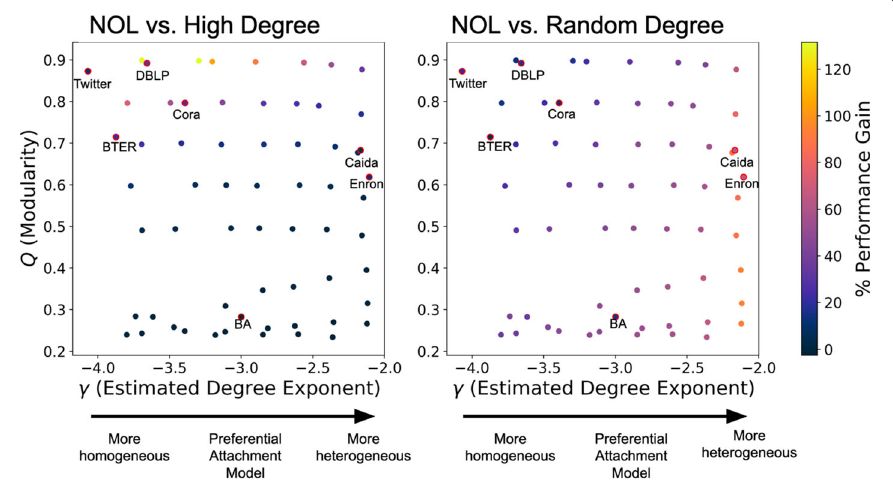
Fig. 6 Results of NOL-HTR parameter search on k and (cid:4) show benefits and limitations of learning in this setting. Experiments over 56 LFR networks generated using different values of parameters γ , the estimated exponent of the degree distribution (horizontal axis), and μ , the extent of cross-community links, which governs modularity Q (vertical axis). Color of points indicates percentgain of best performing NOL-HTR parameters over the high degree (left) or random degree (right) heuristic methods. NOL-HTR consistently outperforms both heuristics with variation depending on network